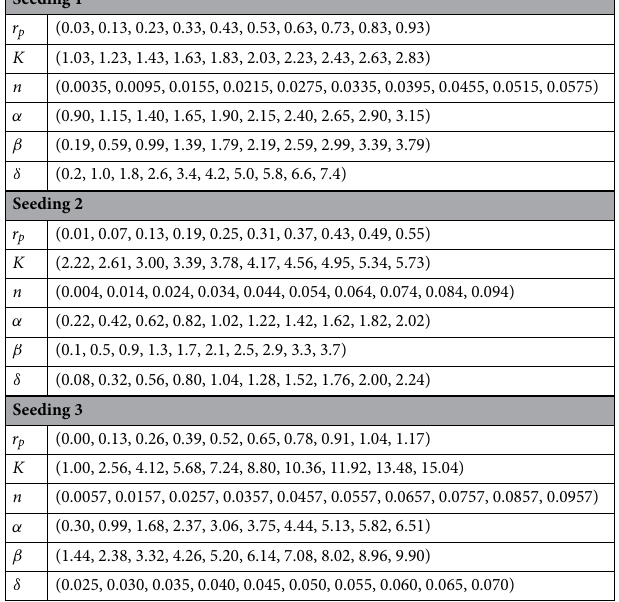
Table 1. Grid values for parameter estimation through grid-search.